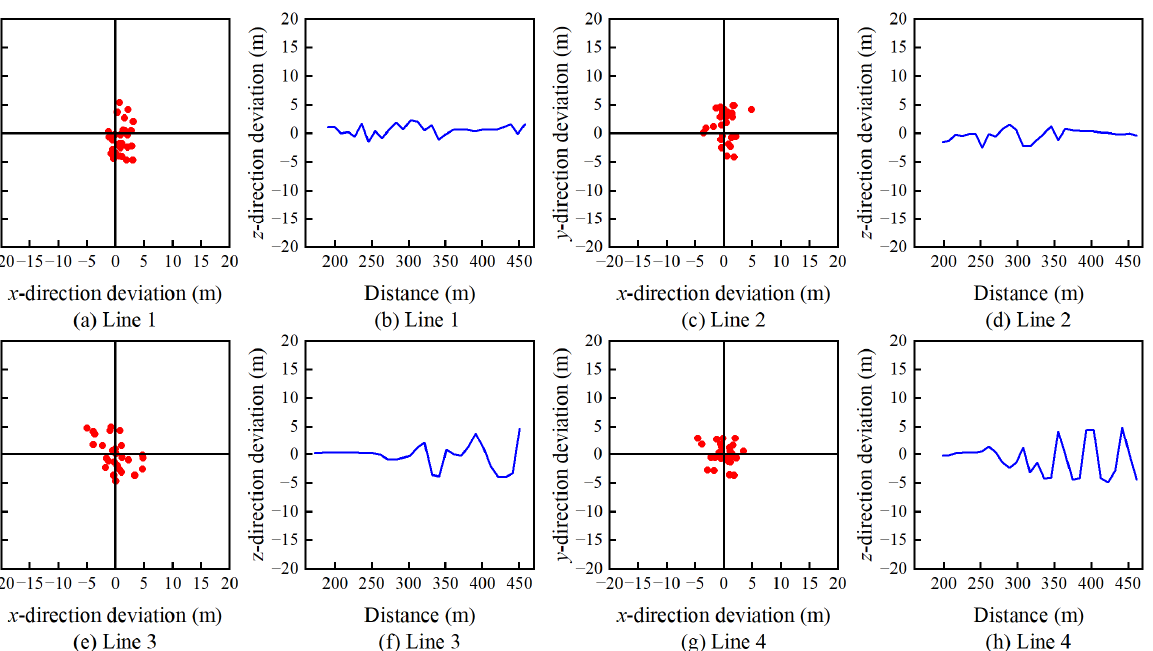
Figure 8. Error distribution of positioning results.